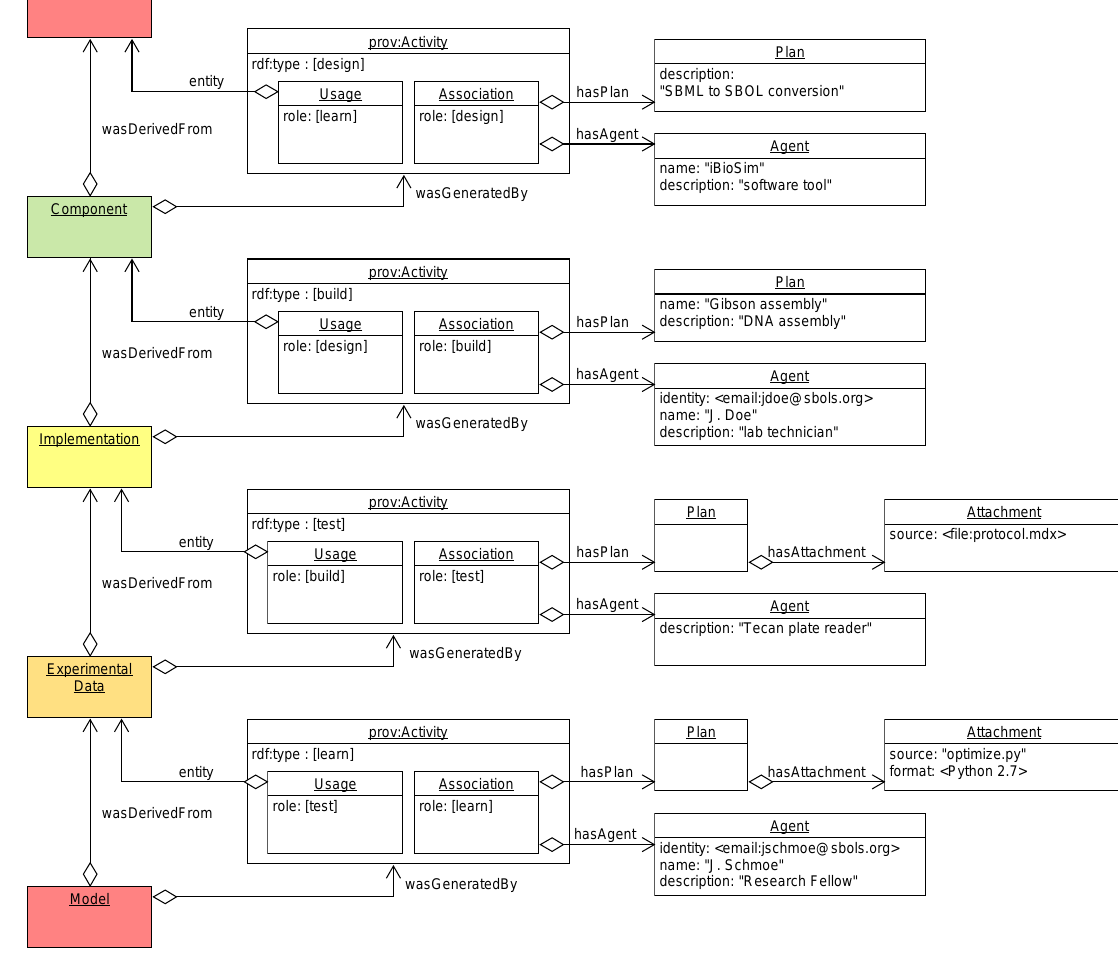
Figure 28: An example data structure representing an idealized workflow for model-based